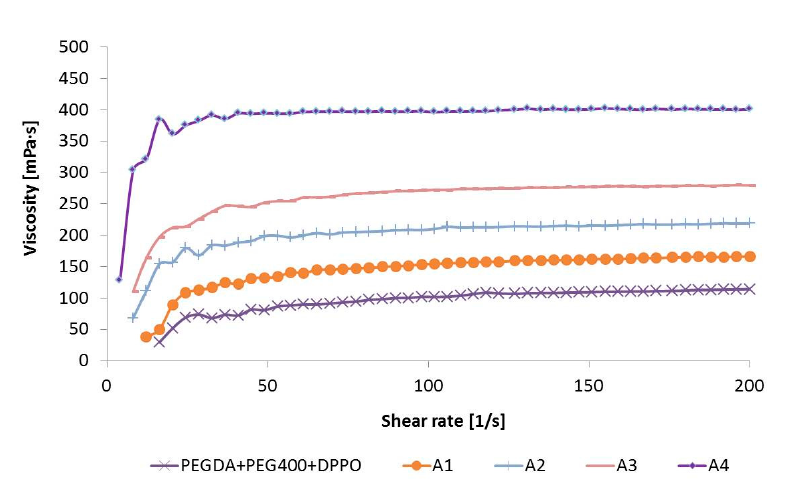
Figure 3. Viscosity curves of the placebo and ATH suspensions.